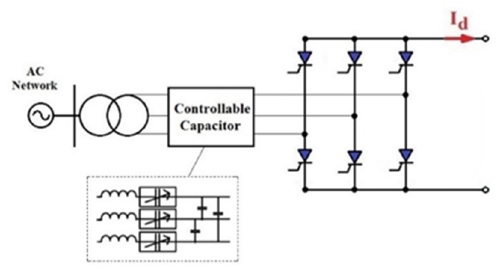
Figure 29. Hybrid bipolar HVDC transmission system.